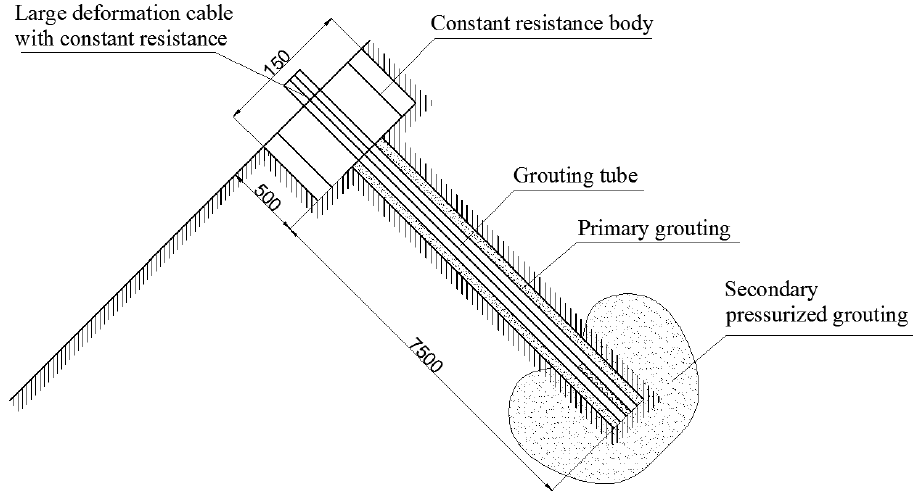
Figure 9. Double pressurized grouting.